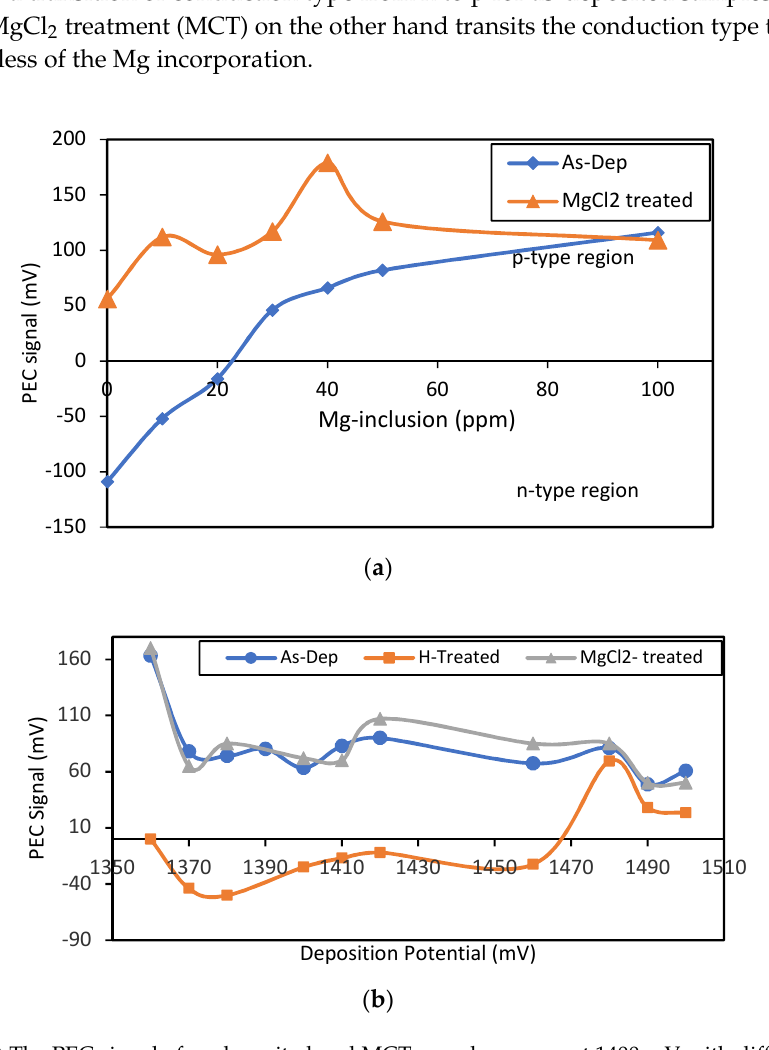
Figure 5. ( a ) The PEC signal of as-deposited and MCT samples grown at 1400 mV with different levels (ppm) of Mg inclusion. ( b ) The PEC signal of as-deposited MCT and HT samples grown in a high concentration (~50%) Mg bath at varying cathodic potentials.